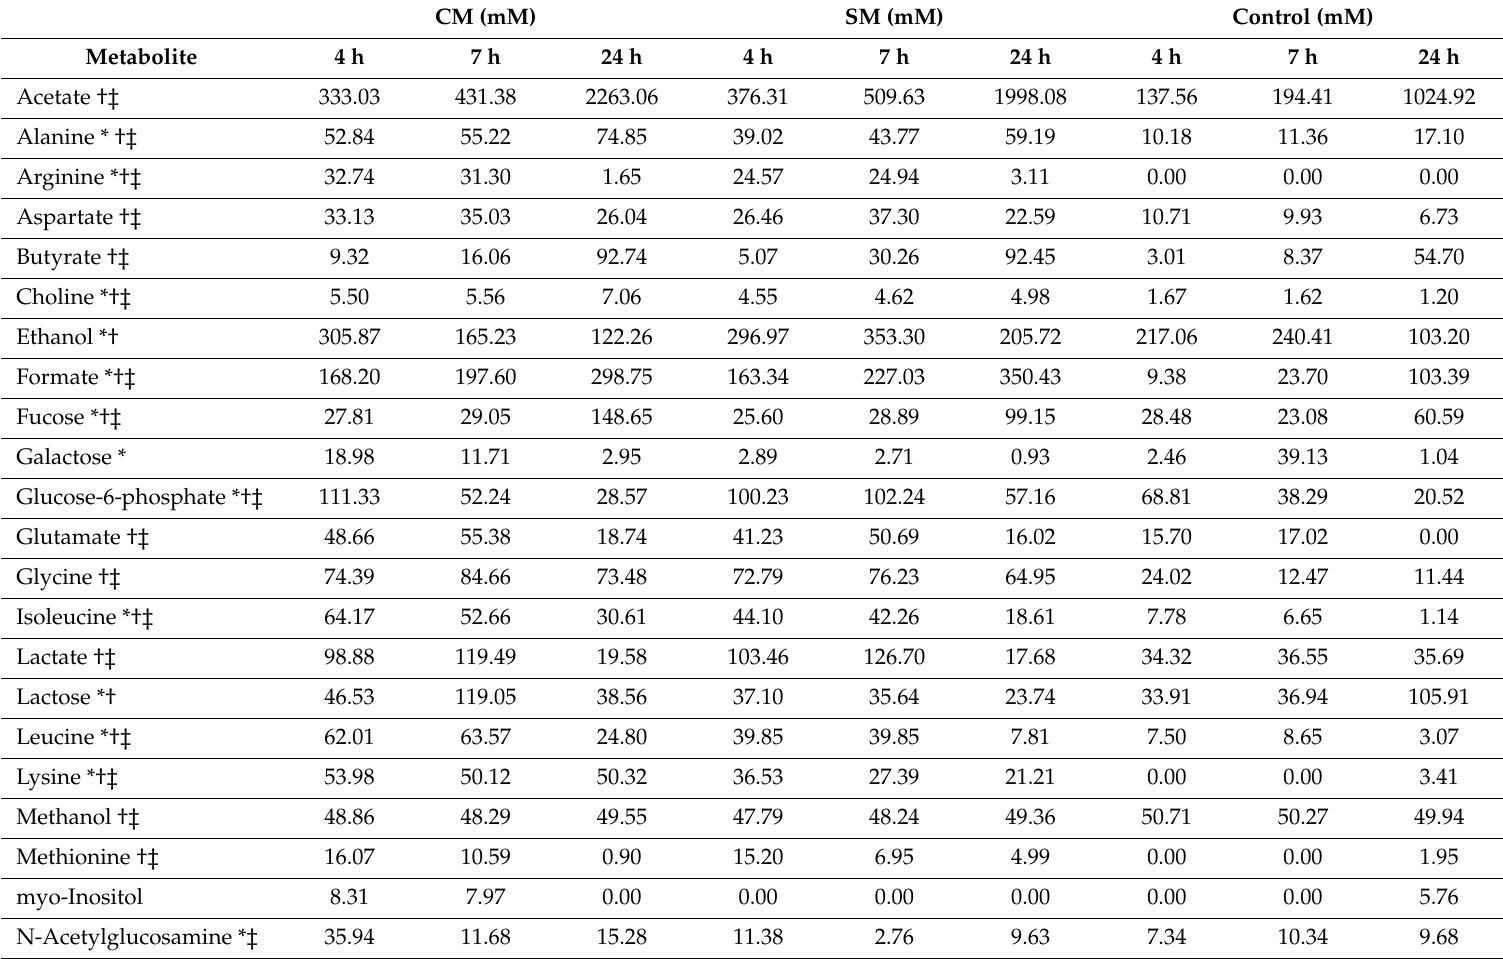
Table A3. Concentrations of metabolites detected by NMR in one-month-old fecal